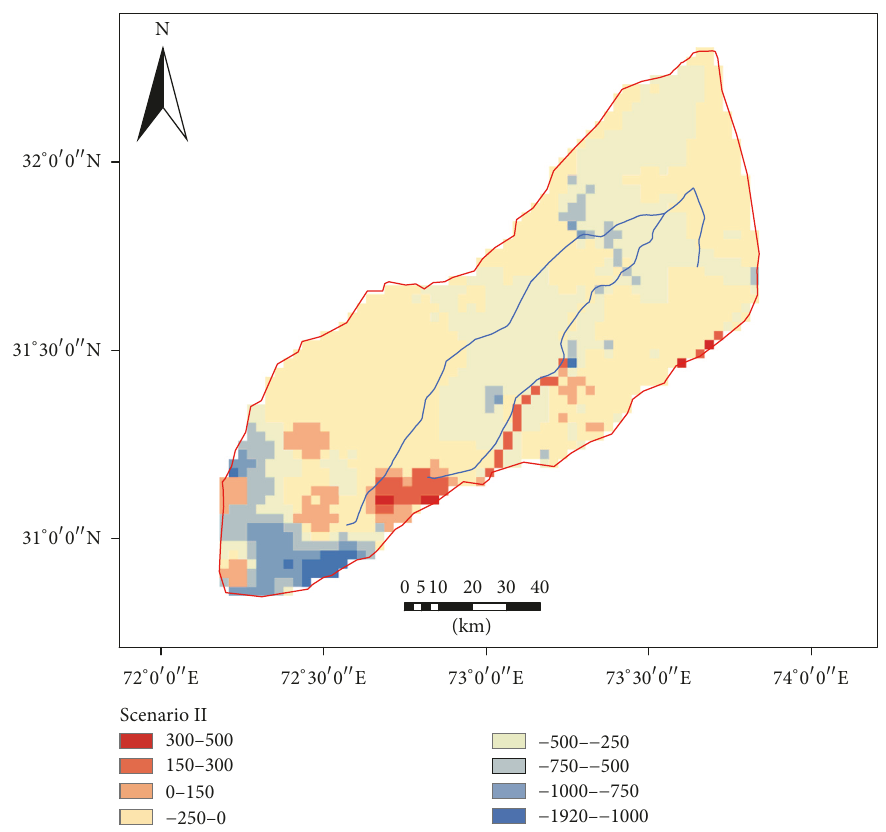
Figure 15: Change in groundwater TDS in the year 2030 (Scenario